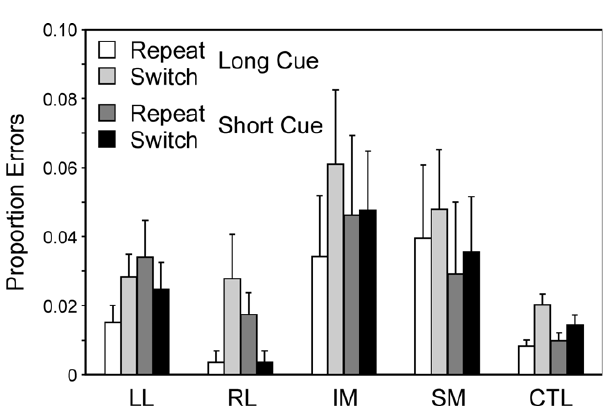
Figure 8. Errors over time. Mean error rates (with standard errors of the mean) of the four patient groups and the controls on the fi rst and second blocks of the Long Cue and Short Cue task conditions. The results are plotted from left to right in the order that the blocks occurred during the session – Short Cue, Long Cue, Long Cue, Short